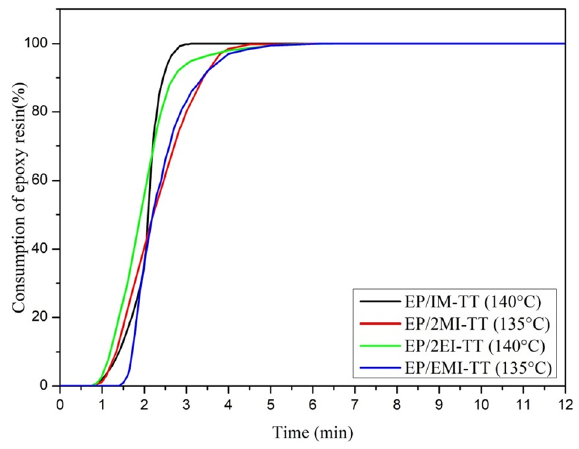
Fig. 9 Conversion of EP blends tested in isothermal